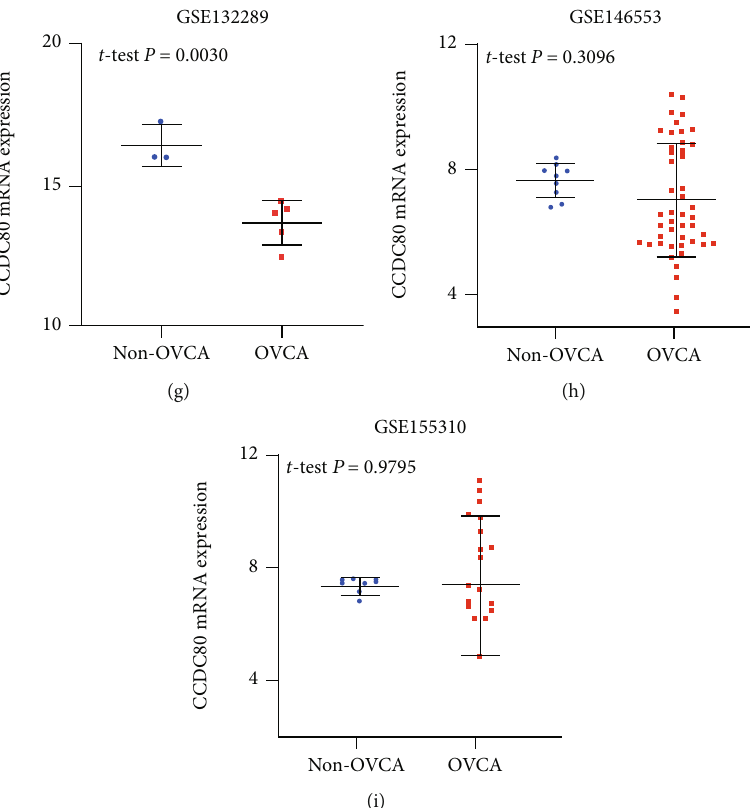
Figure 2: Scatter plots of CCDC80 protein (a) and mRNA (b) – (i) expression of OVCA and the corresponding normal